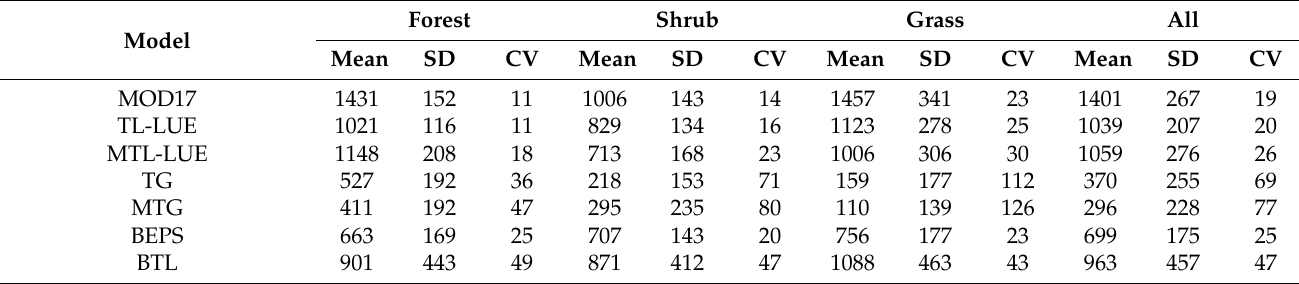
Table 3. Mean (gC m − 2 yr − 1 ), standard deviation (SD, gC m − 2 yr − 1 ), and coefficient of variation (CV, %) values of multiple annual GPP estimates in forest, shrub, grass, and all pixels.